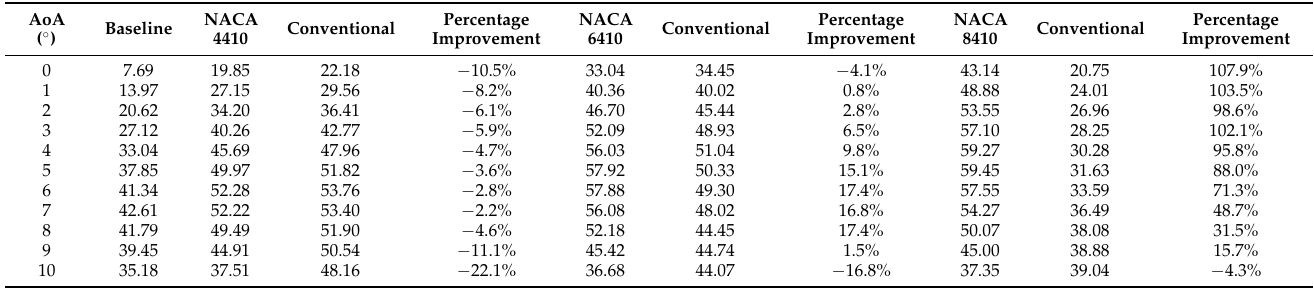
Table 6. Comparison of the endurance ratio of morphing and conventional